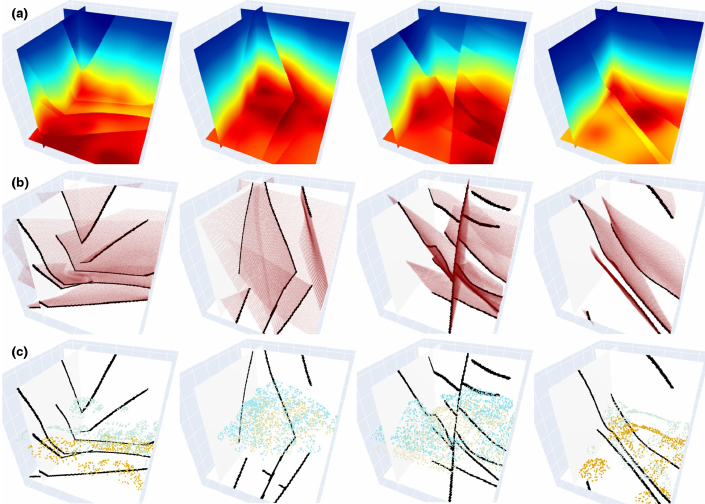
Figure 4. A total of four pairs of 3-D training data samples are shown. The first row shows 3-D synthetic implicit structural models used as labels in training our 3-D network. The second and third rows, respectively, display the fault and sparse horizon points extracted from the models (first row), which are used together as inputs to the CNN.